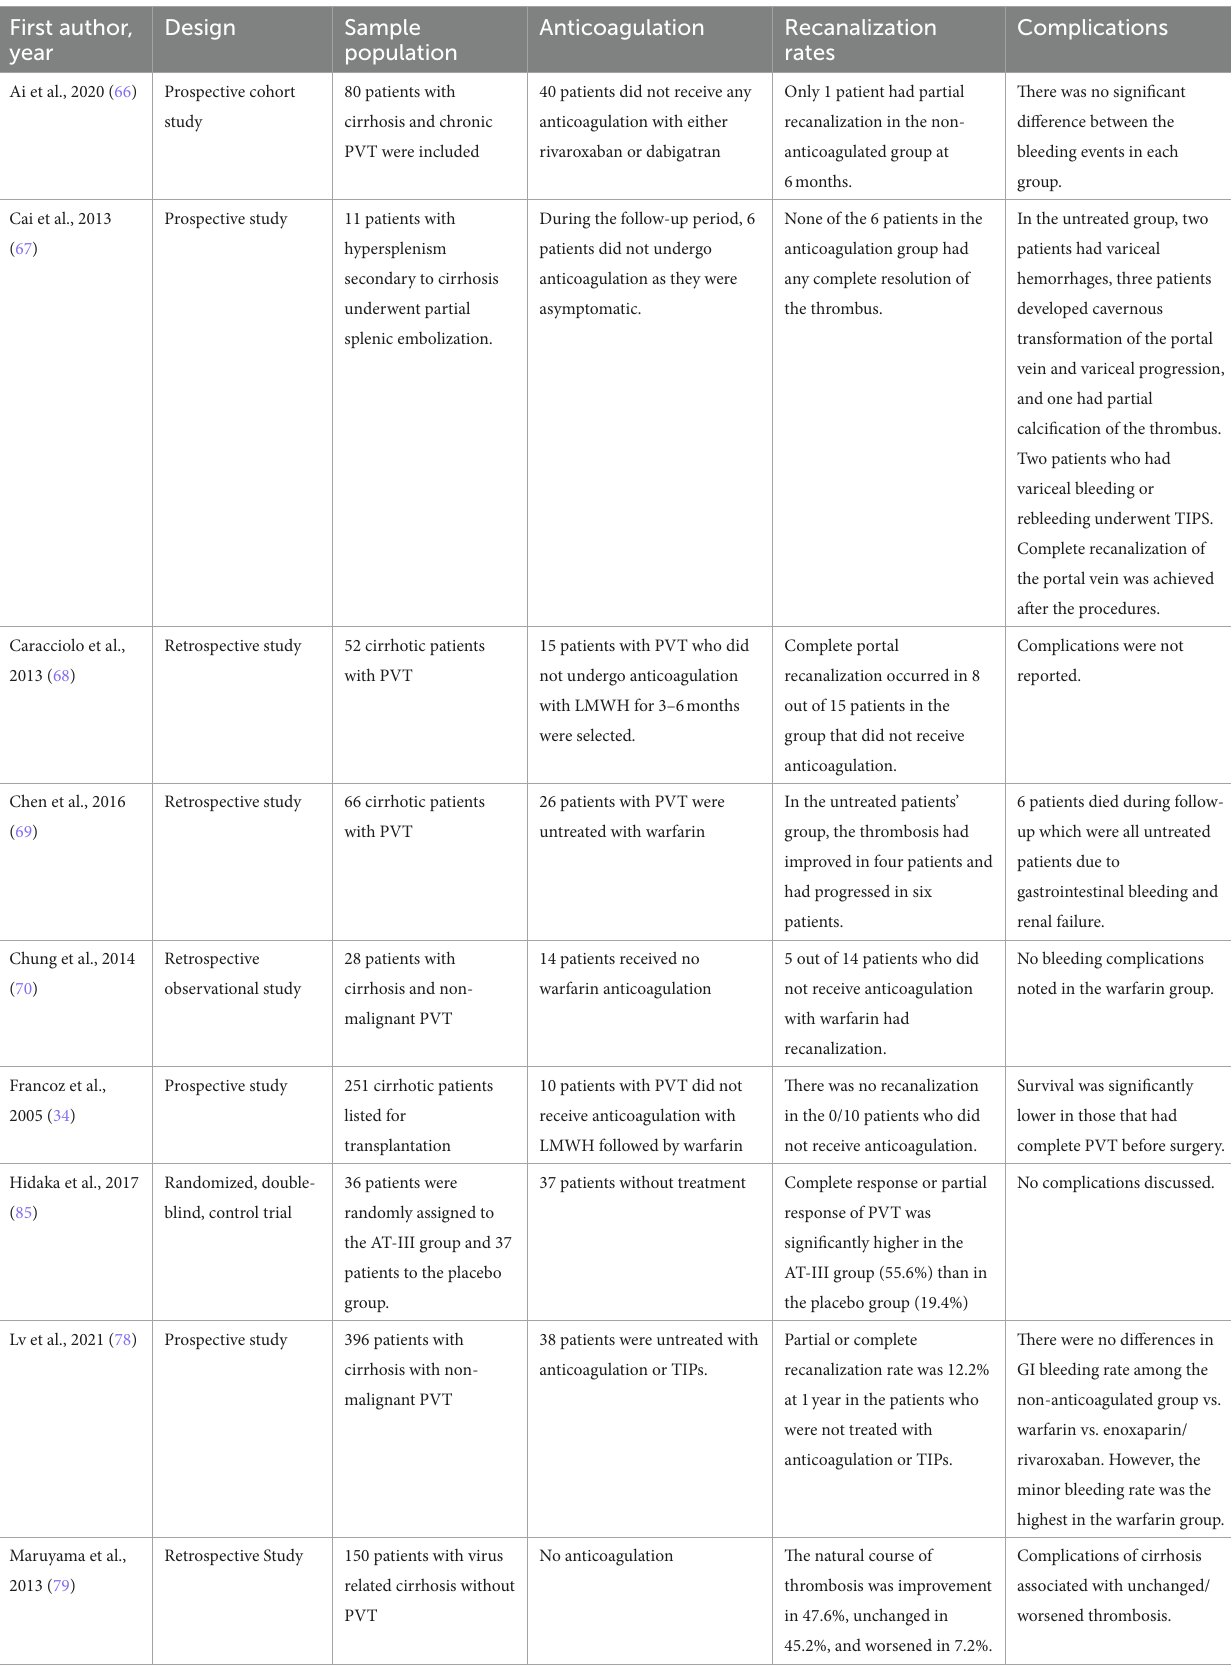
TABLE 2 Studies which depict the natural history of PVT in cirrhotic without